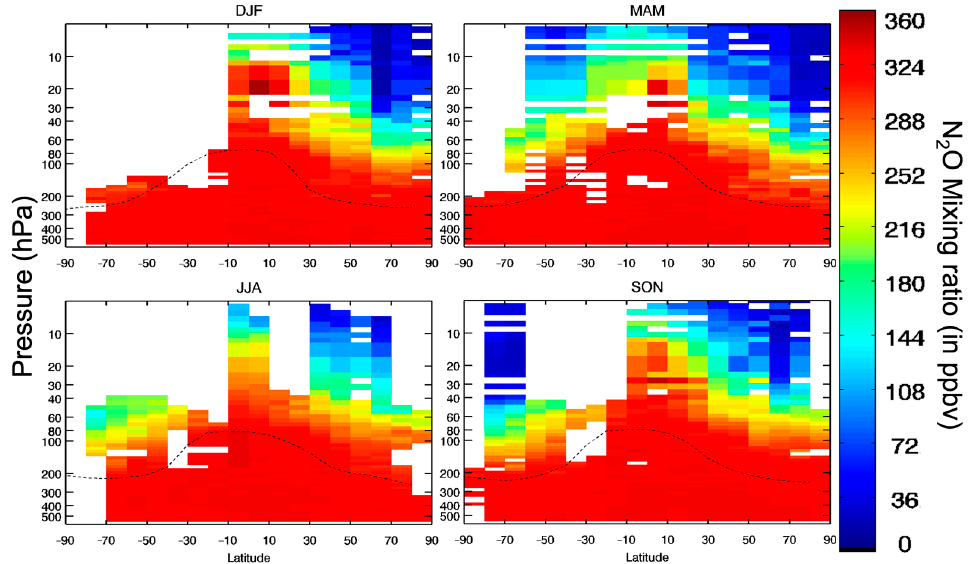
Figure 7. N 2 O mixing ratio zonal mean in 2018 (the trend observed in Figure 5 applied to the data) for December-January-February (DJF), March-April-May (MAM), June-July-August (JJA), and September-October-November (SON). Zonal means are calculated from error-weighted measurements (see Section 2.3) with 10° latitude bins and 60 levels of pressure (from 600 hPa to 5 hPa). The dashed line represents the tropopause pressure according to ECMWF ERA-interim [48].